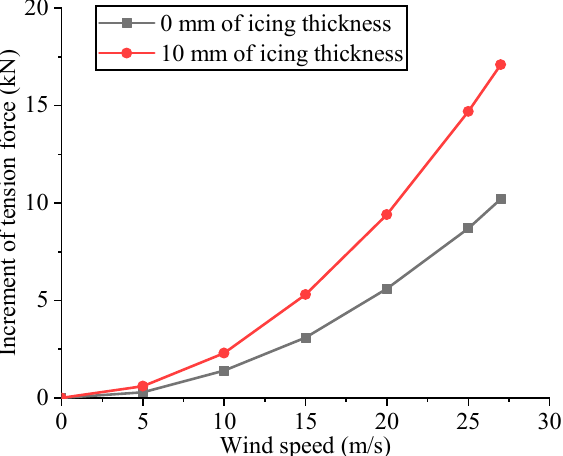
Figure 14. The influence of wind speed on tensile force of suspension cable.